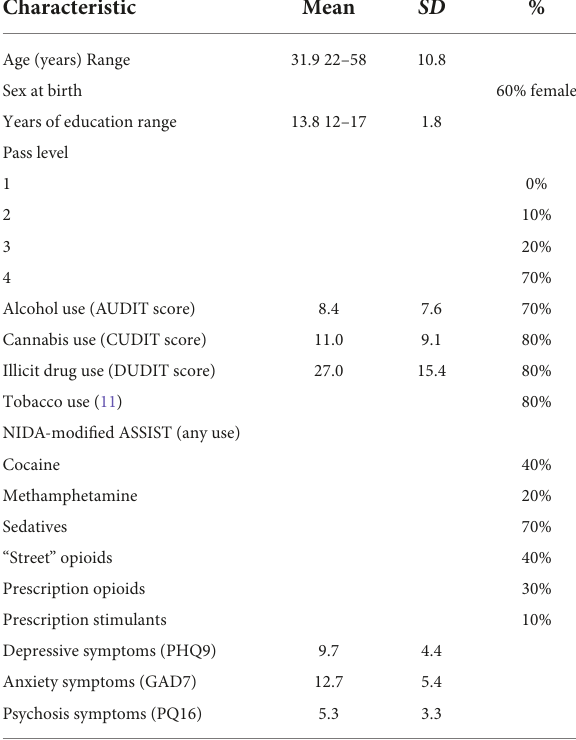
TABLE 1 Participant